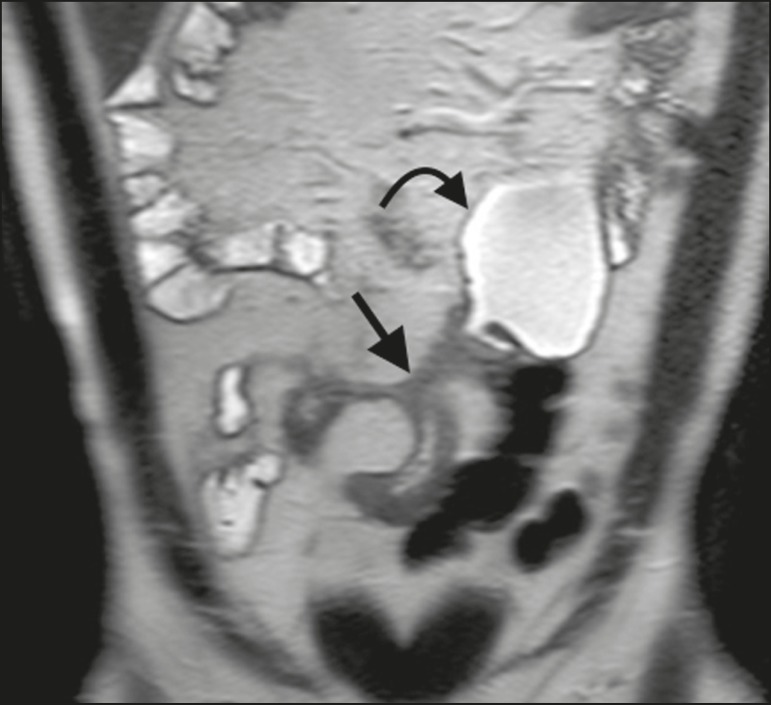
Coronal T2-weighted MRE sequence showing stenosis and enteroenteric fistula in the distal ileum, with the “clover-like” sign (straight arrow). Note also the upstream dilatation of the prestenotic segment (curved arrow).